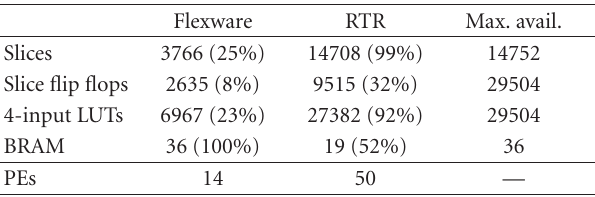
Table 2: The resource usage in the Flexware and RTR aligner on a Spartan XC3S1600E-4FG484.